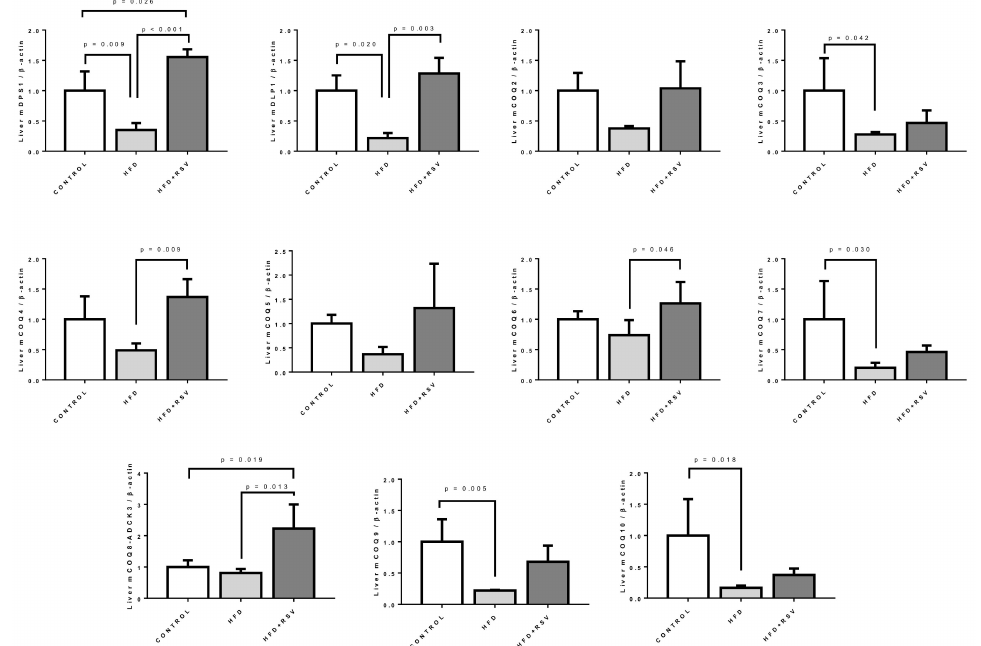
Figure 2. mRNA levels of COQs genes in liver. Messenger RNA levels were determined by qPCR as indicated in Section 2.5. The housekeeping gene β -actin was used as loading control. Statistical di ff erences are included in each figure ( n = 4) per group. mDPS1: Decaprenyl-diphosphate synthase subunit 1; mDLP1: Decaprenyl-diphosphate synthase subunit 2; mCOQ2–mCOQ10: mouse COQs